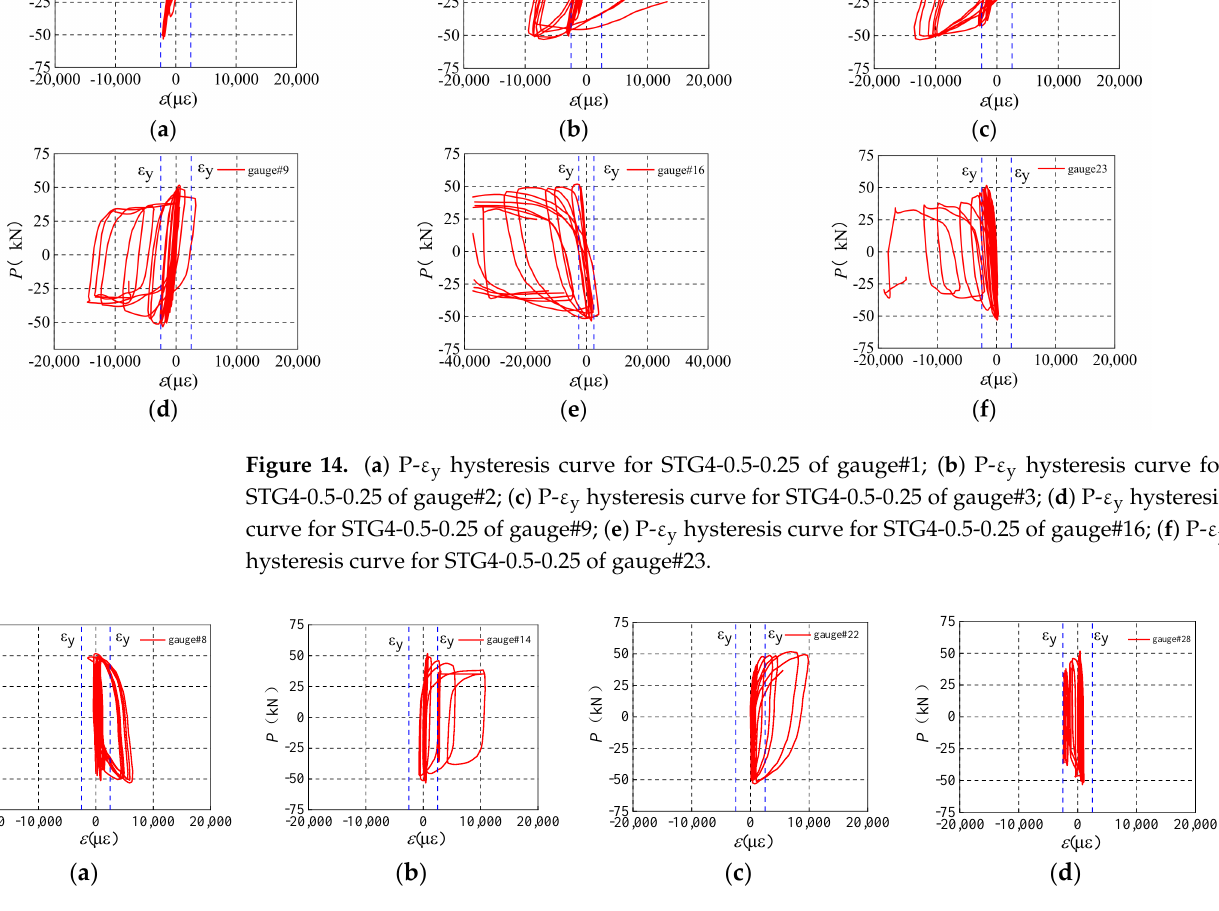
Figure 15. ( a ) P- ε x hysteresis curve for STG4-0.5-0.25 of gauge#8; ( b ) P- ε x hysteresis curve for STG4- 0.5-0.25 of gauge#14; ( c ) P- ε x hysteresis curve for STG4-0.5-0.25 of gauge#22; ( d ) P- ε x hysteresis curve for STG4-0.5-0.25 of